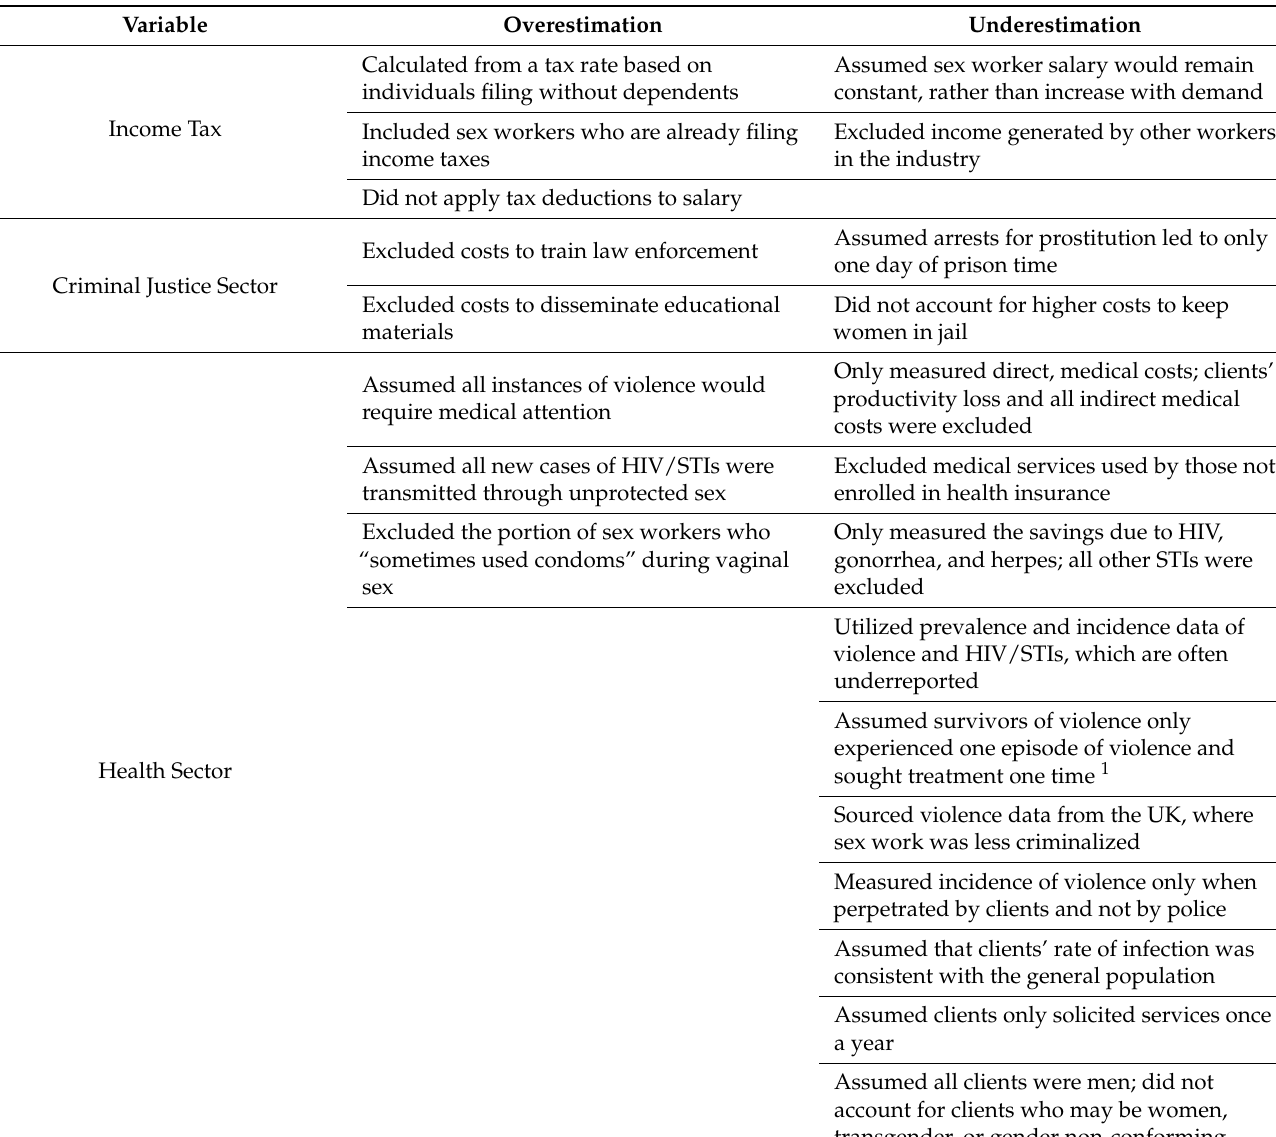
Table A1. Annual income tax revenue and health sector savings per sex worker in sensitivity analysis, by variable